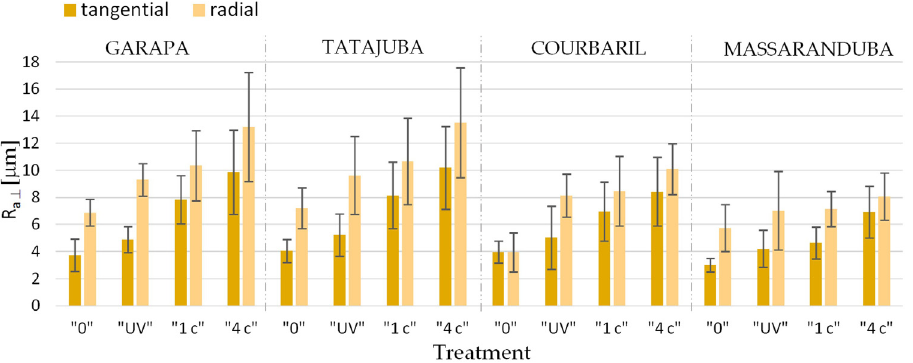
Figure 3. Roughness ( R a ⊥ ) perpendicular to the fibres of tested wood species: “O”—fresh wood, “UV”—after 24 h of UV irradiation, “1 c”—after one cycle of artificial weathering, “4 c”—after four cycles of artificial weathering.